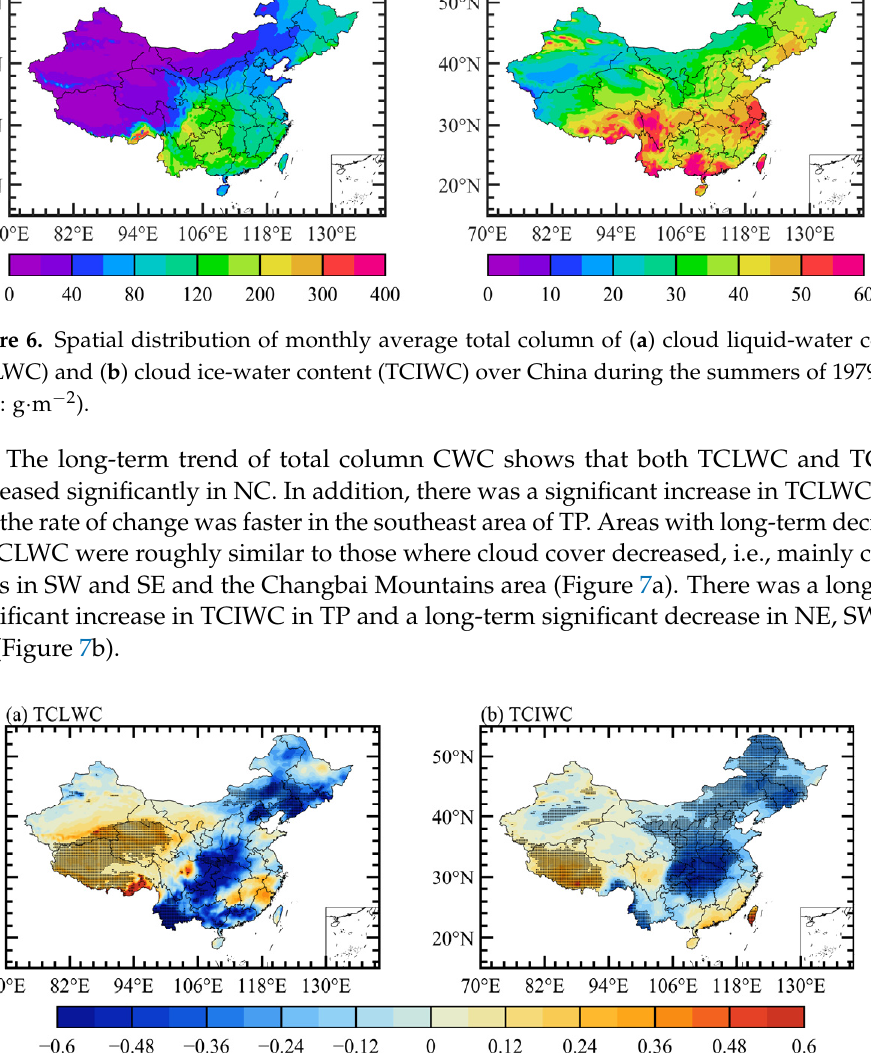
Figure 7. Spatial distribution of ( a ) TCLWC and ( b ) TCIWC trends over China during the summers of 1979–2020 (unit: g·m − 2 ·yr − 1 ). The stippled areas indicate that the trends passed the significance test at the 95% confidence level.